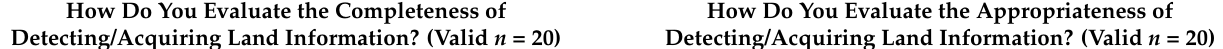
Figure 2. Responses of LI experts about the effectiveness of detecting and updating processes of LI. Table 3. Responses of LI experts about the completeness and appropriateness of detecting LI.